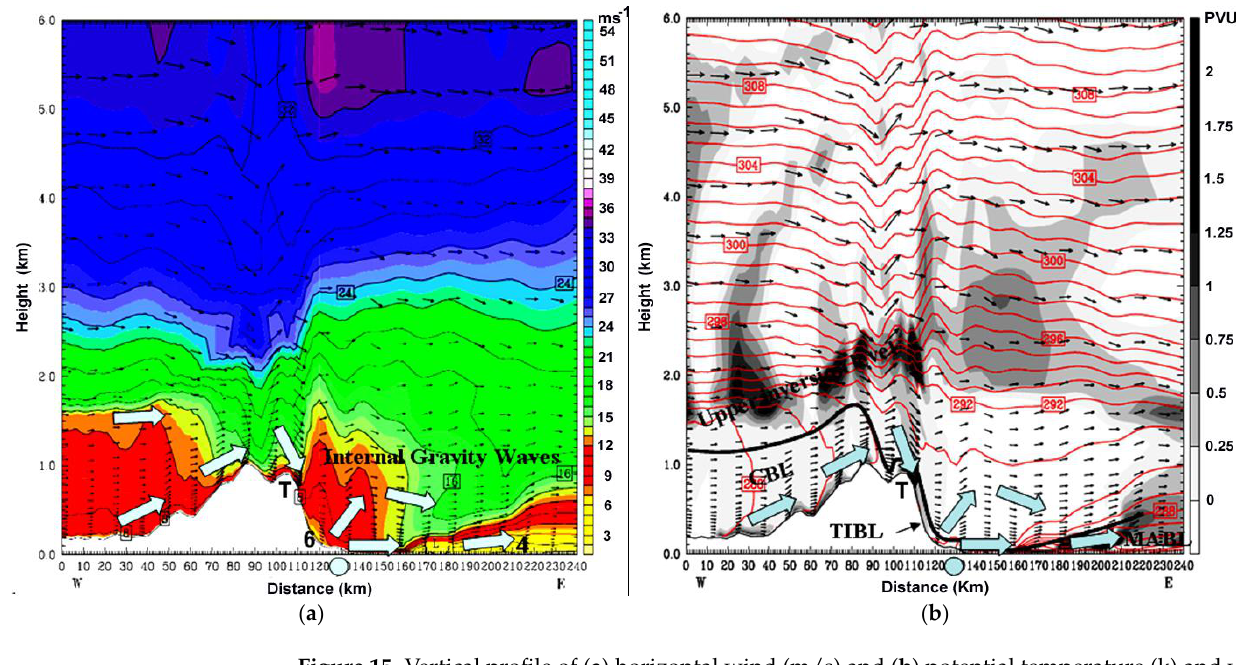
Figure 15. Vertical profile of ( a ) horizontal wind (m/s) and ( b ) potential temperature (k) and wind speed (m/s) in the third domain of WRF model simulation at ( a ) 15:00 LST, 30 March 2004. Tick line, CBL, TIBL, T, MABL and a small circle on the bottom of the figures denote the top of the convective boundary layer, thermal internal boundary layer, Mt. Taegulyang, marine atmospheric boundary layer, and Gangneung city, respectively.